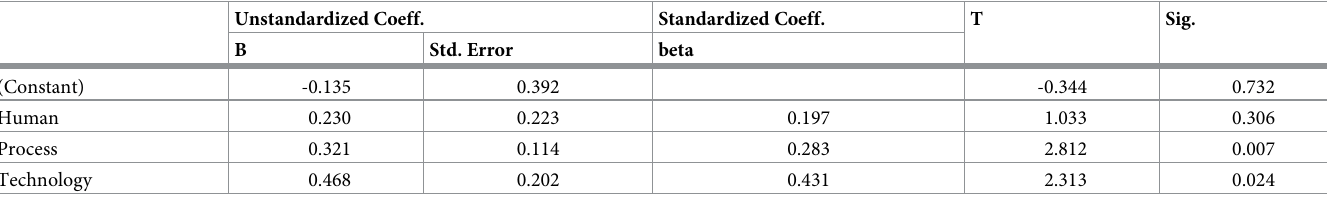
Table 19. Multi regression test.